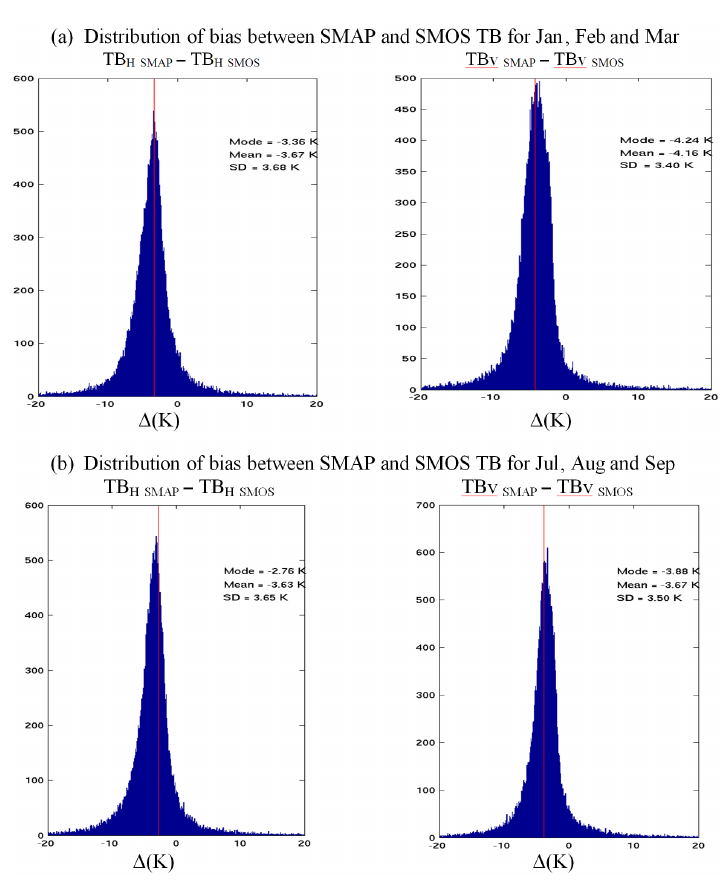
Figure 6. Distribution of bias between SMAP and SMOS L3 TB for pixels with less than 0.01 (1%) water fraction for January–February– March (a) and July–August–September (b) , H polarisation (right panels) and V polarisation (left